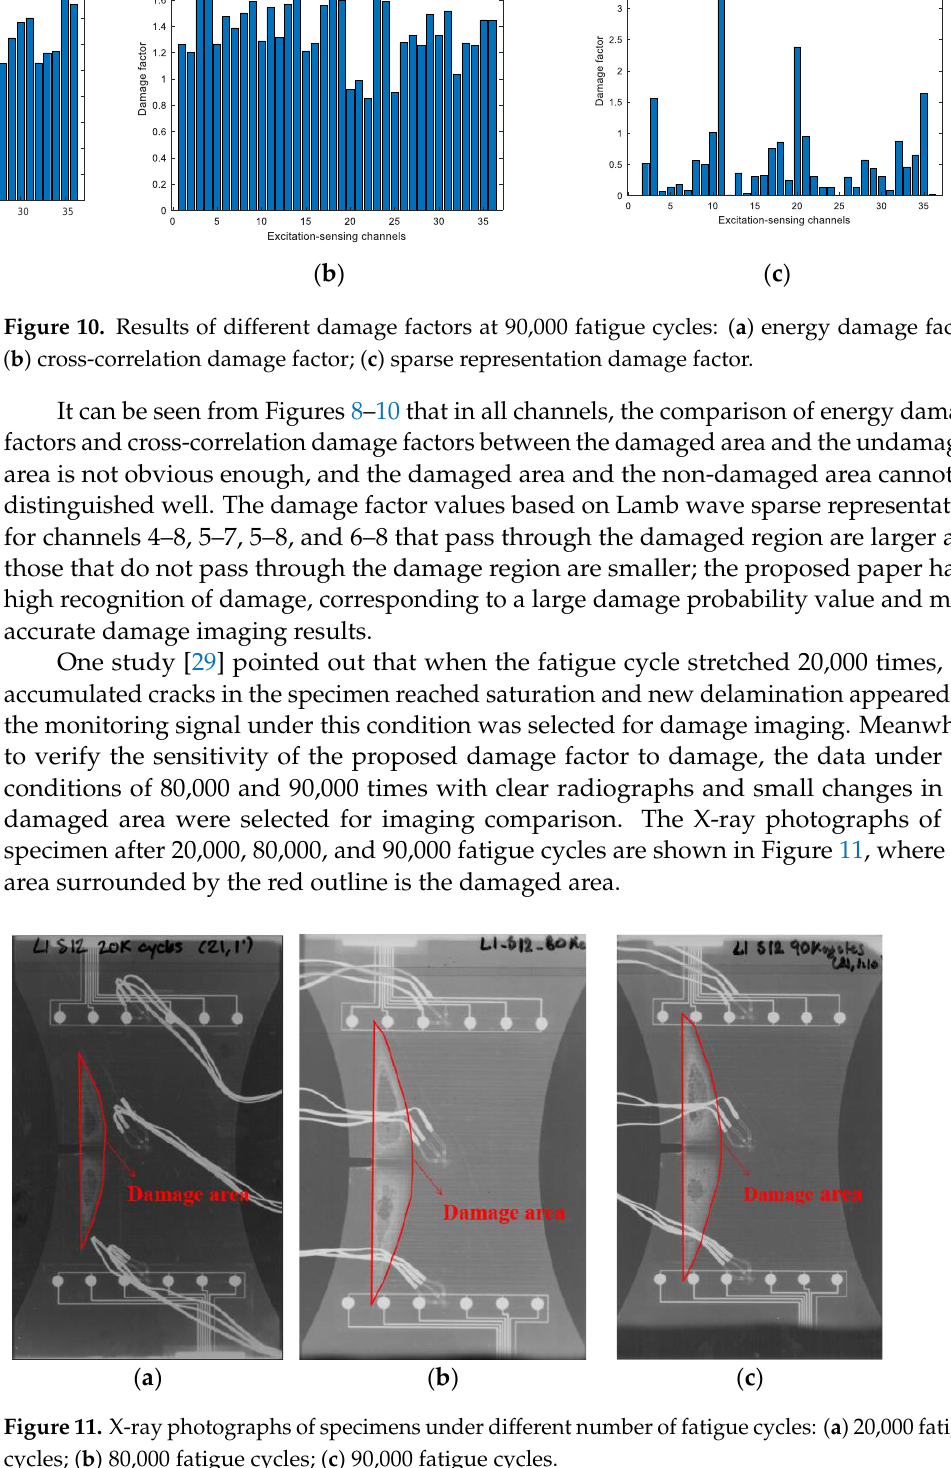
Figure 4b. Based on the real specimen size, a specimen of size 15.24 cm × 25.4 cm is created